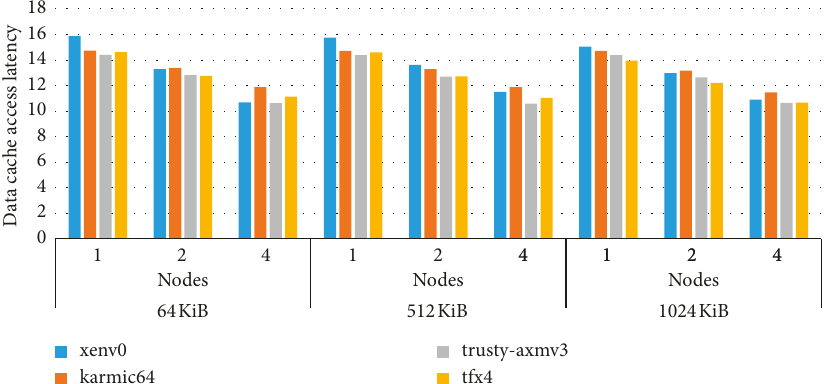
Figure 13: Evaluation of the data access latency in the COTSon framework when using the matrix multiplication benchmark by varying cache size, number of nodes of the distributed system, and different Linux distribution (“xenv0” “trusty-axmv3” Ubuntu 14.04, and “tfxv4” Ubuntu 10.10). The DSE shows that the data-cache access latency is almost similar in each (cid:31) (cid:31) Linux distribution, but it is lowering when we increase the number of nodes. Thus, multiple-node configuration can be more convenient in the DF-Threads execution